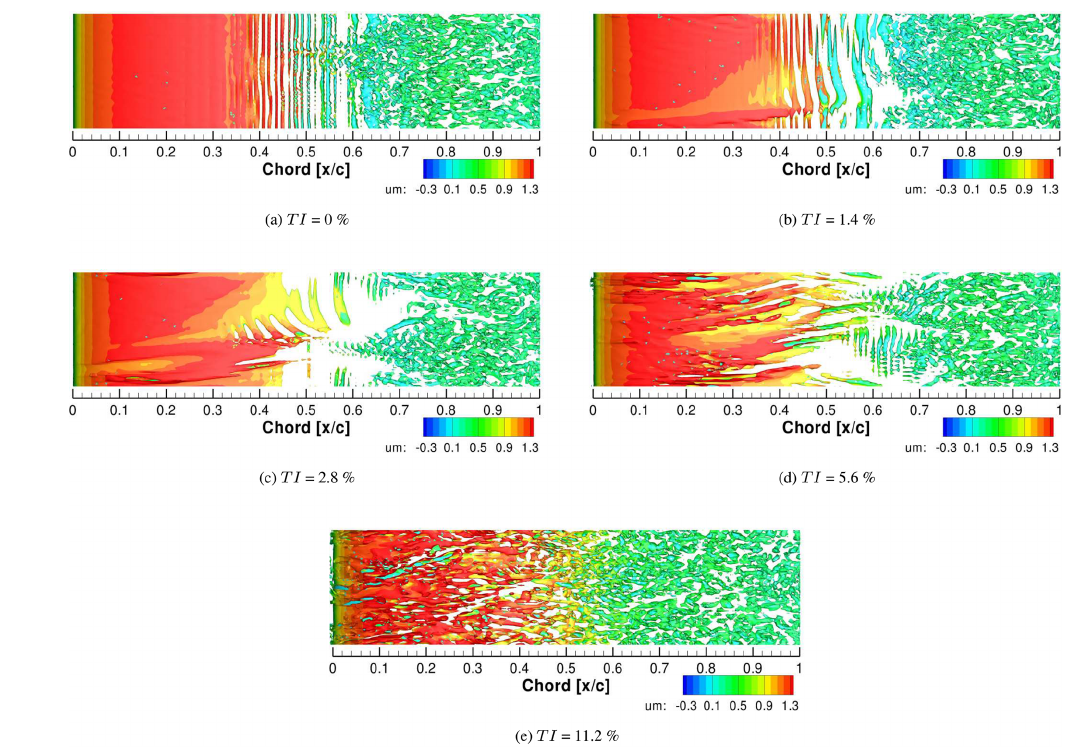
Figure 7. Instantaneous iso-surfaces of the Q criterion ( Q = 250) colored by the mean streamwise velocity normalized by u 2 ∞ /c 2